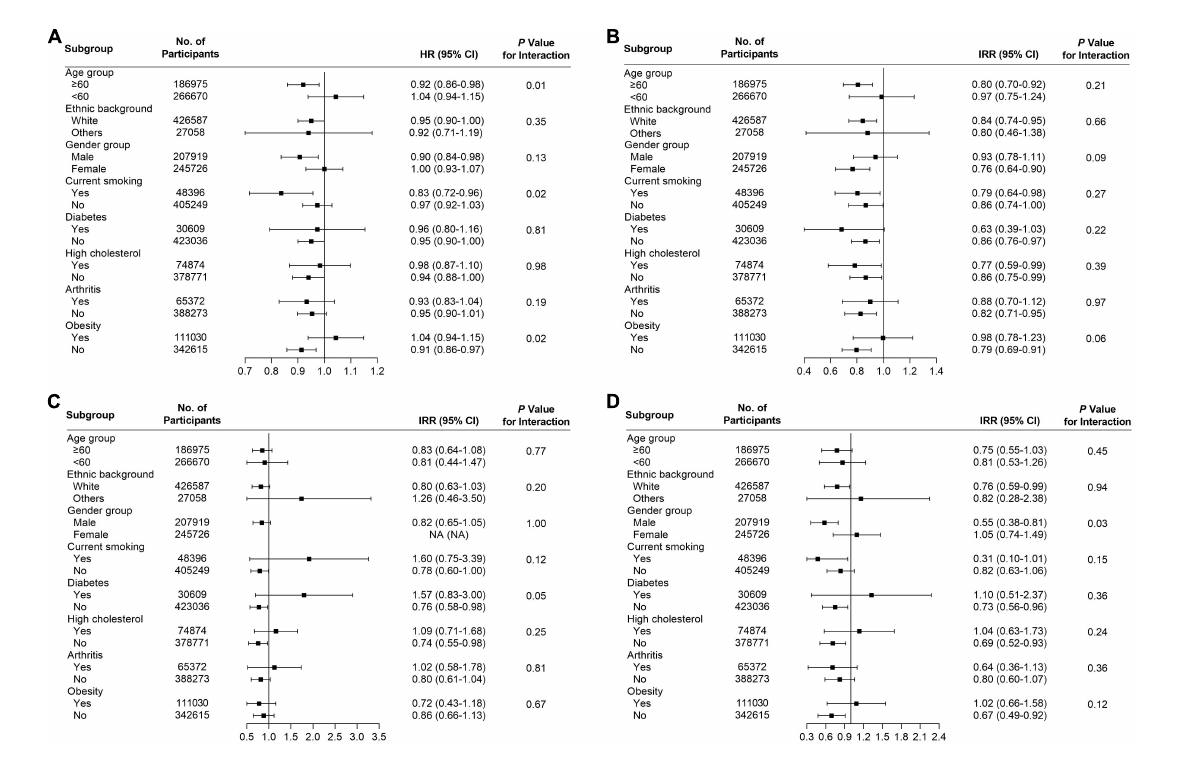
FIGURE3 Subgroup analysis for (A) all cancers, (B) lung cancer, (C) prostate cancer, and (D) rectum cancer to analyze the potential modification effects between age, ethnic background, gender, smoking, diabetes, high cholesterol, arthritis, and